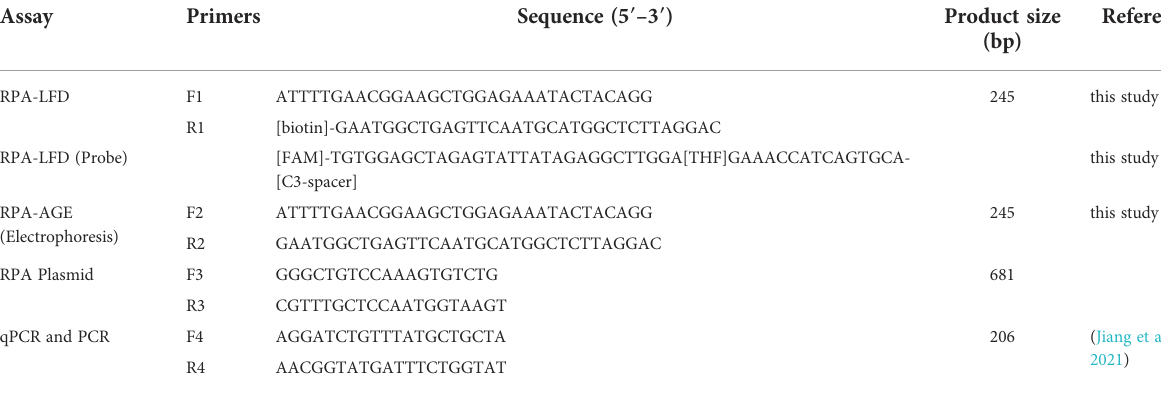
TABLE 2 Primer sequences and product size for different detection methods.